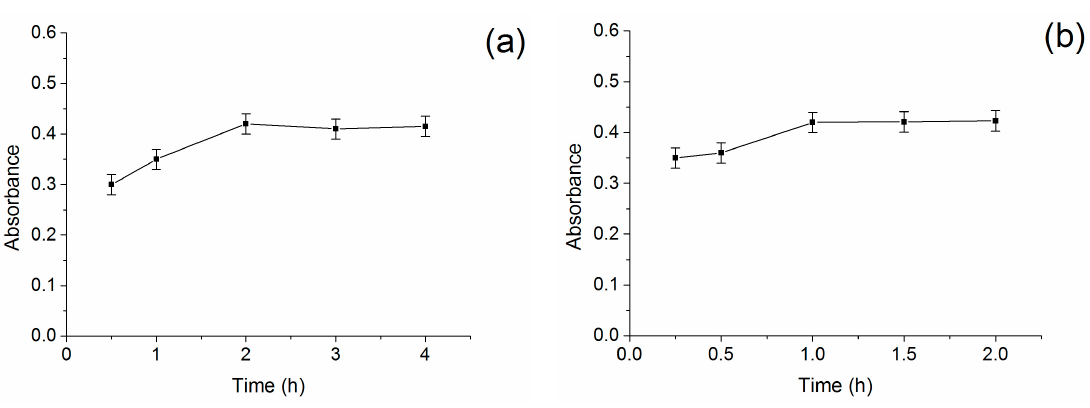
Figure 7. ( a ) Effect of incubation time on screening; and ( b ) effect of eluting time on screening.